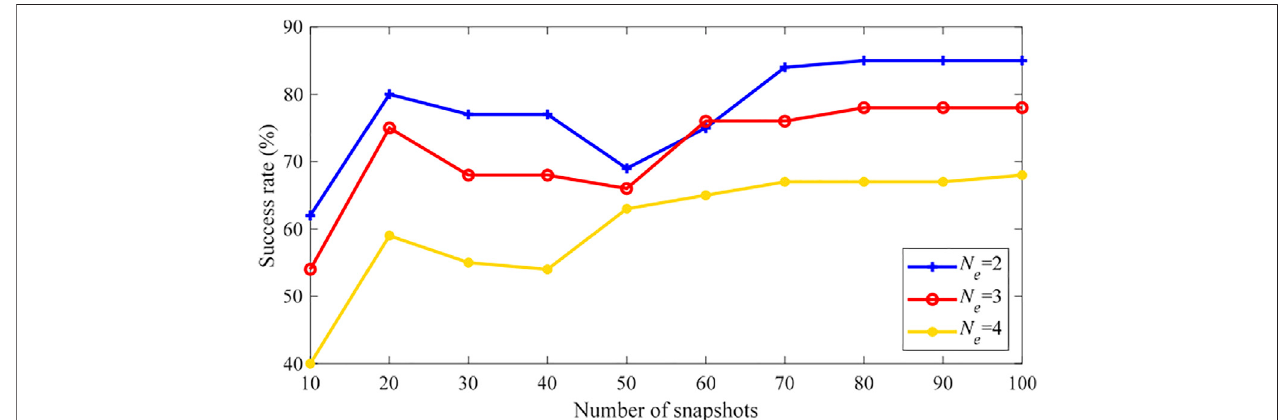
FIGURE 3 | PEI success rate of the IEEE 14-bus system using empirical MEVs (Case 1).